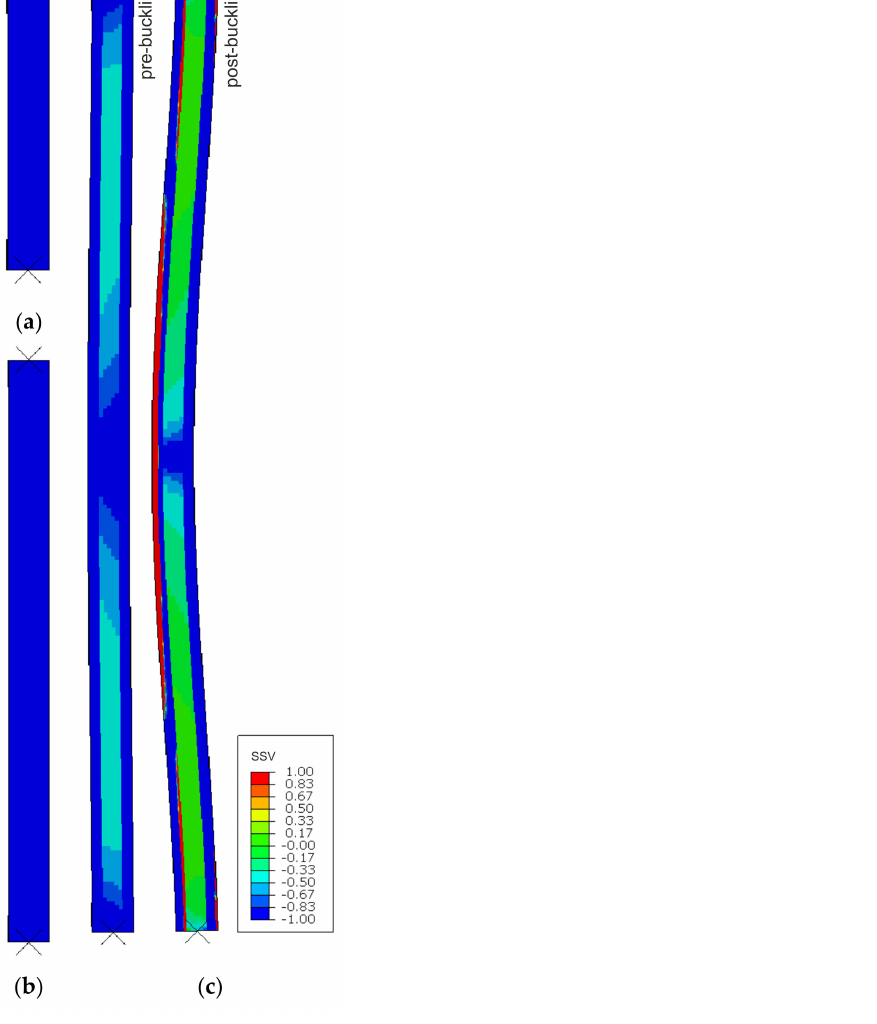
Figure 7. SSV distribution in compression simulations of ( a ) L1, ( b ) L2, and ( c ) L3